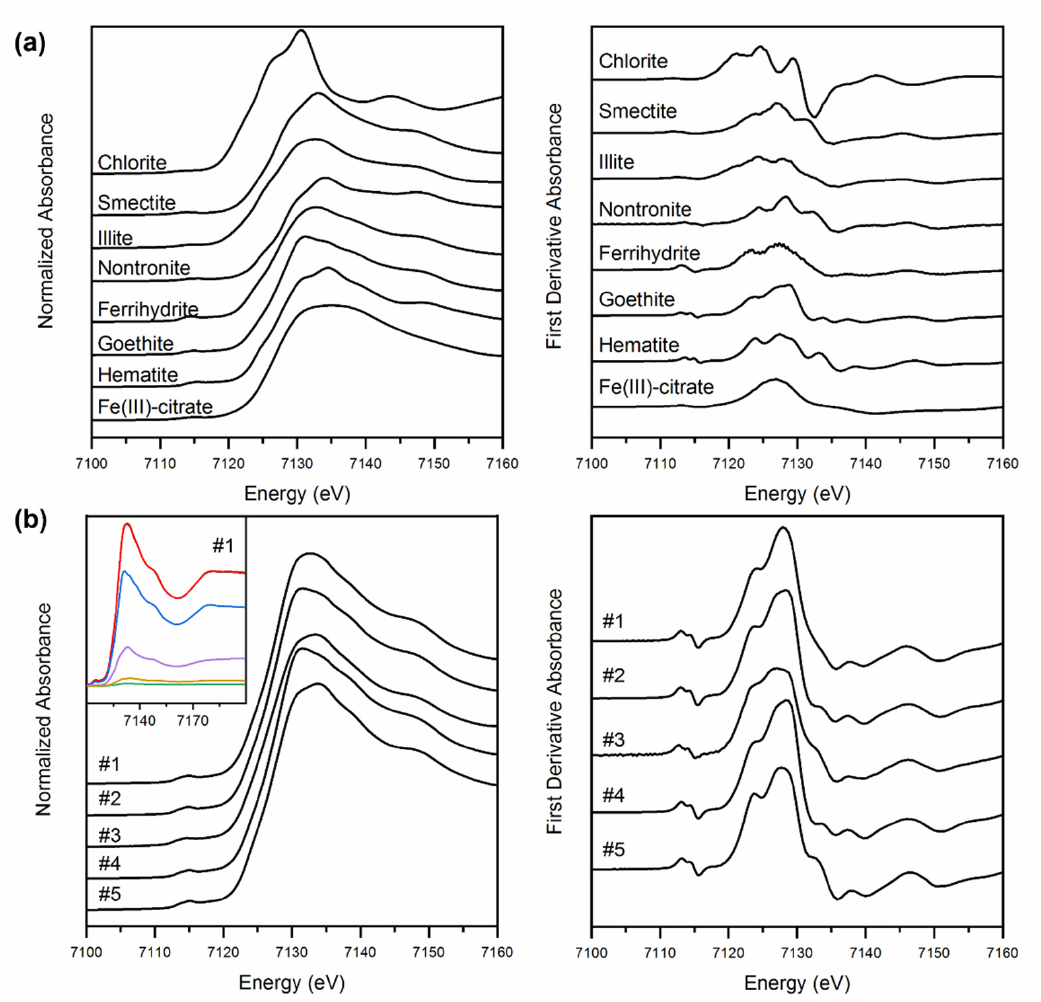
Figure 1. Normalized XANES (on the left) and corresponding first-derivative spectra (on the right) for standards ( a ) and sediment samples ( b ). The inset on the bottom left corner shows an example of LCF (sediment #1): data (in black), best fit (in red), goethite (in blue), smectite (in purple), hematite (orange), ferrihydrite (in green). It is worth to note that the red and black lines perfectly overlap. LCF was applied to the normalized Fe K-edge XANES spectra (Table 2). Three to Table 2. Results for the LCF performed on the normalized Fe K-edge XANES spectra.